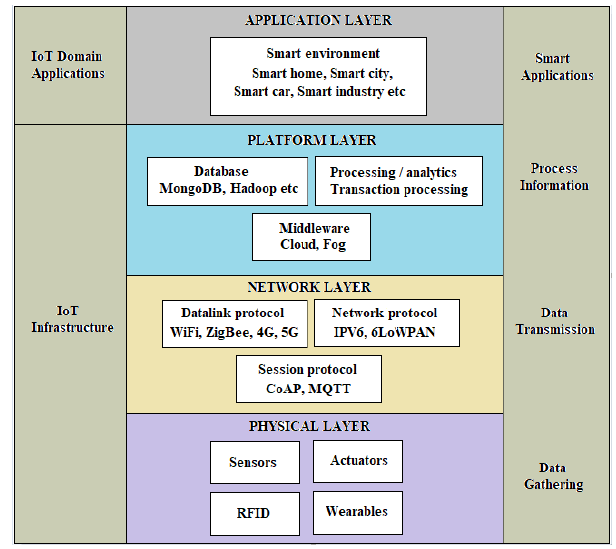
Figure 1 . The IoT Architecture in Smart